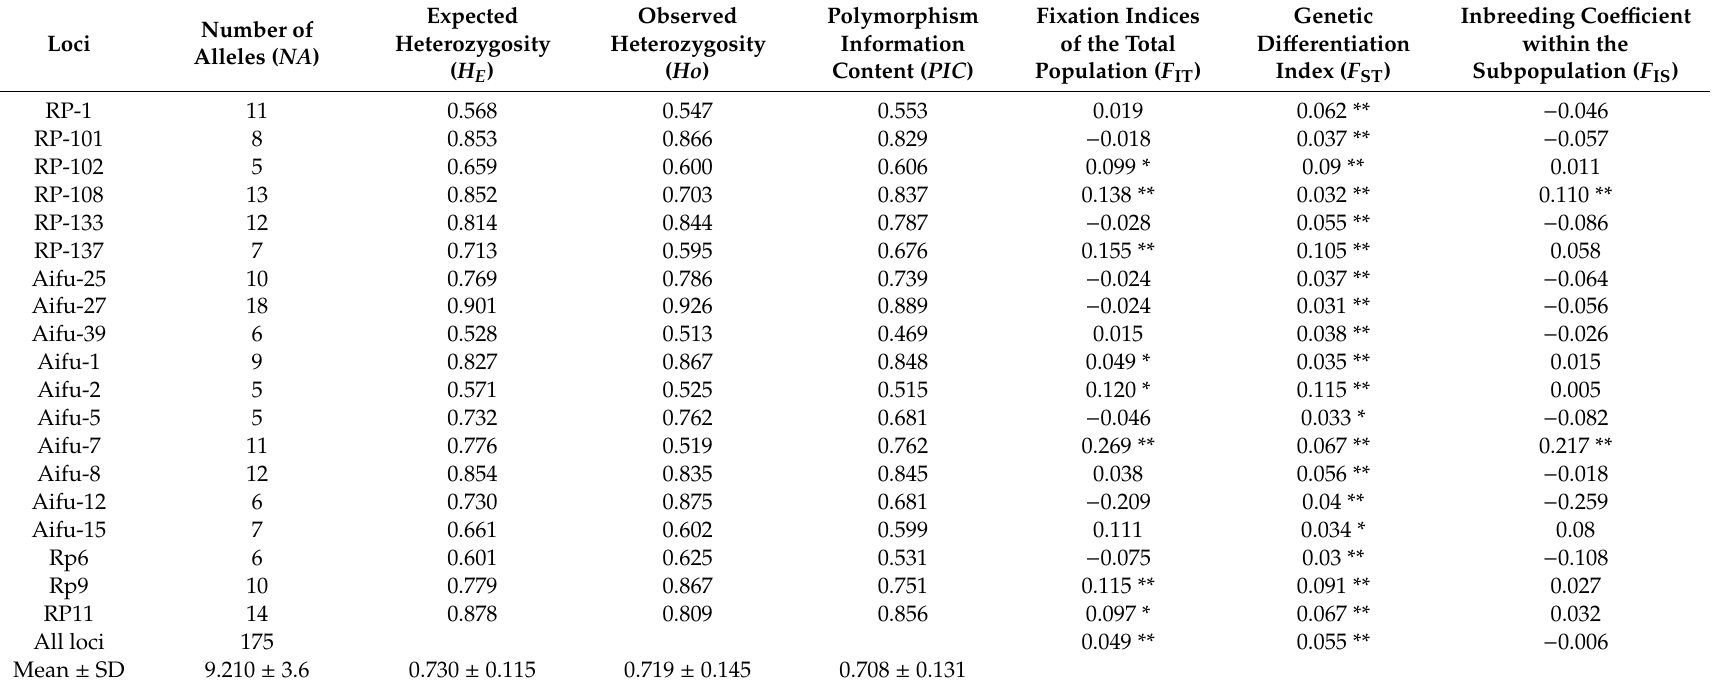
Table 2. The genetic characteristics of 19 STR from all the samples. * Significant ( p < 0.05); ** ( p <